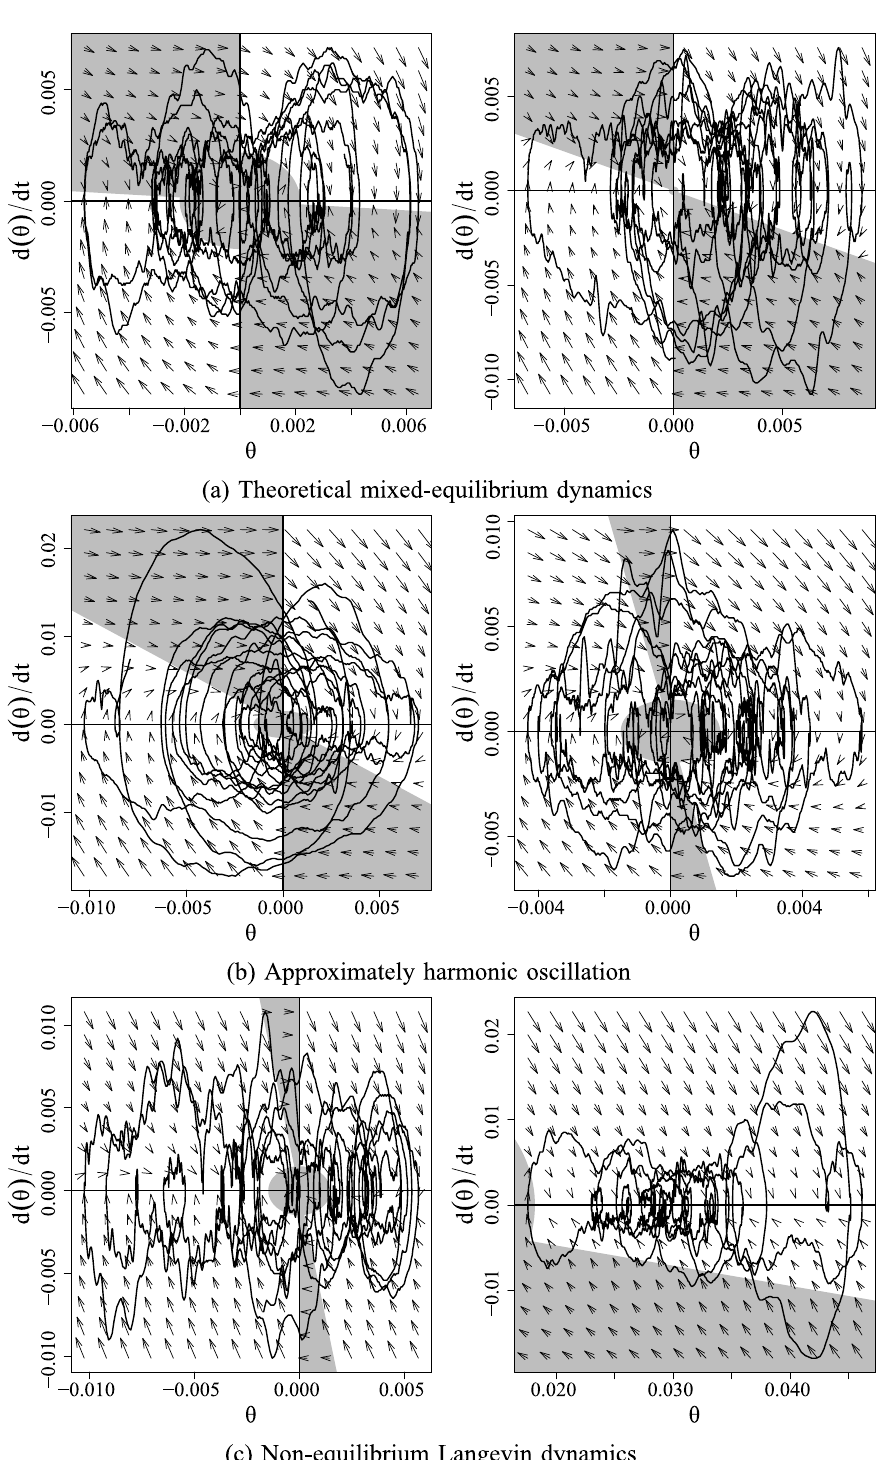
Fig 10. Phase portraits of observed body tilt angle series with estimated intermittent activation structures and vector fields. The horizontal axis is the COM or tilt angle position and the vertical axis is its velocity. The shaded region represents behavior where P and D are equal to zero. In (a), the estimated parameters match theoretical expectations, showing mixed equilibrium behaviors. In (b) and (c), the nonlinear mechanisms are fit in unique ways that deviate from their theoretically expected